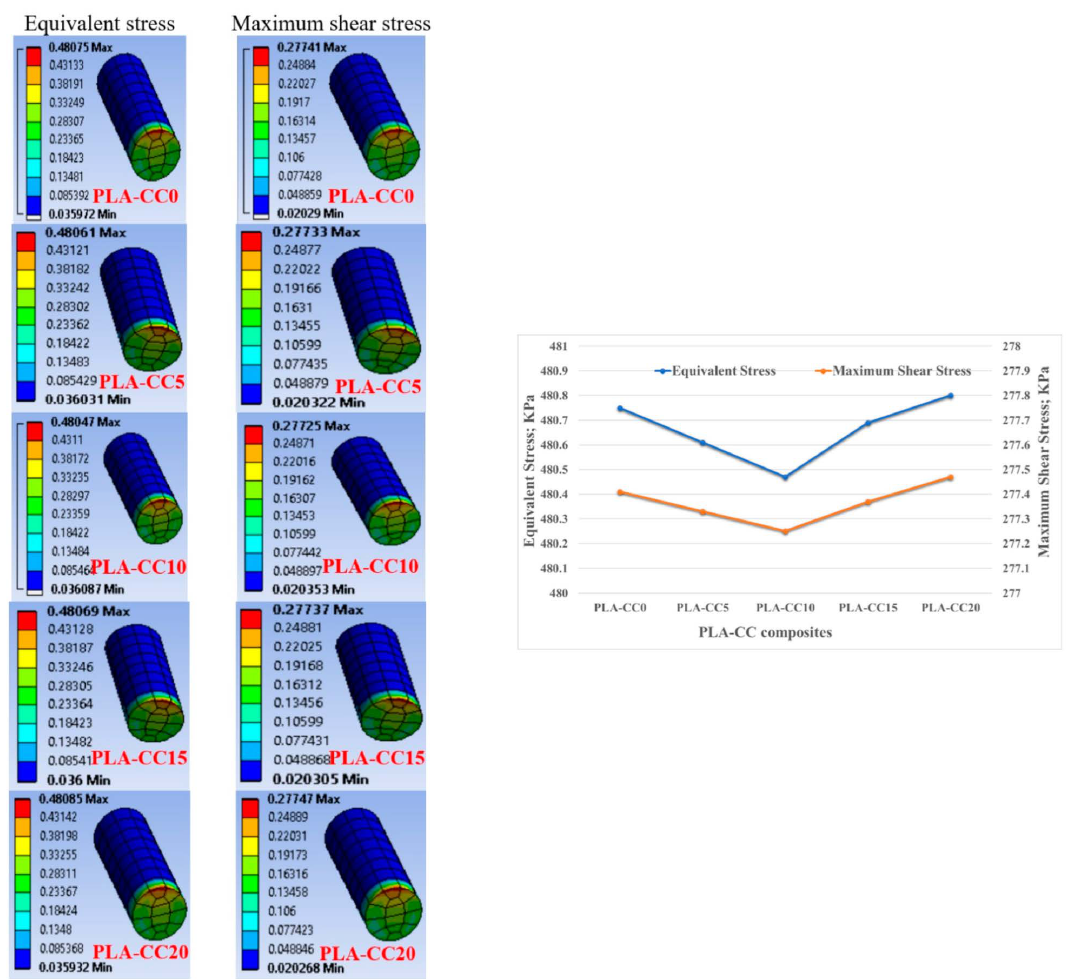
Figure 16. Contact stresses distribution along the PLA-CC composite